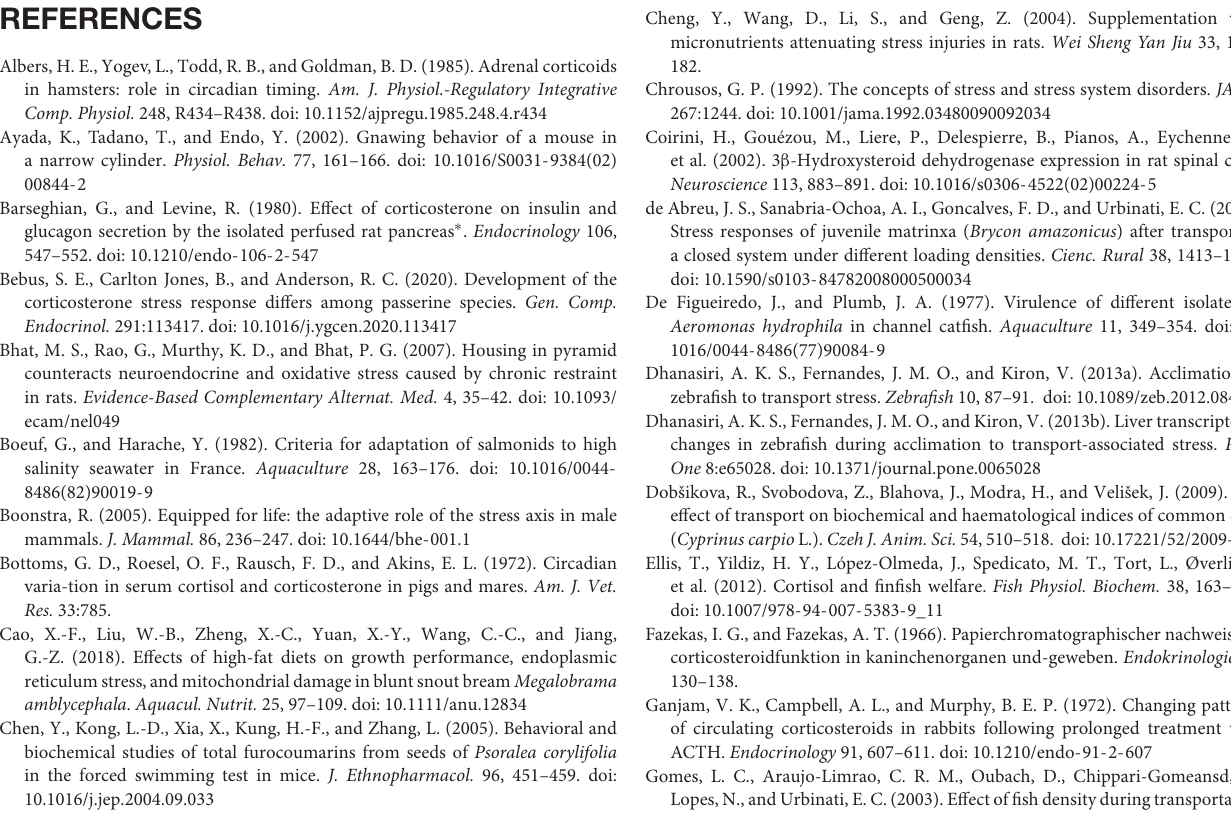
Supplementary Figure 1 | The standard curve of cortisol. Supplementary Figure 2 | The standard curve of